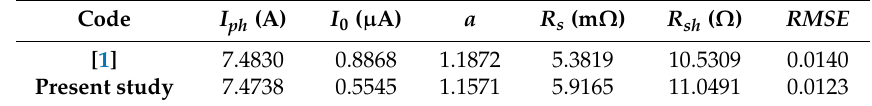
Figure 3. A comparison between the experimental data (green dots) and the calculated characteristic (blue line) for the Schutten Solar STP6–120/36 module. Table 1. Parameter extraction results of the Schutten Solar STP6–120/36 module with those reported in [1].